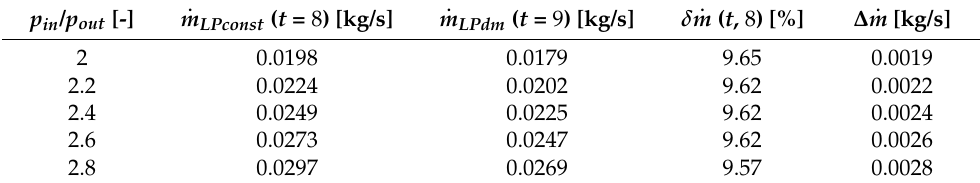
Table 4. Change of the leakage rate by Equation (17) depending on the pressure ratio p in /p out for the initial 8t and the designed geometry 9t of the staggered seal, RC = 0.315 mm, T in = 300 K, p out = 10 5 Pa.